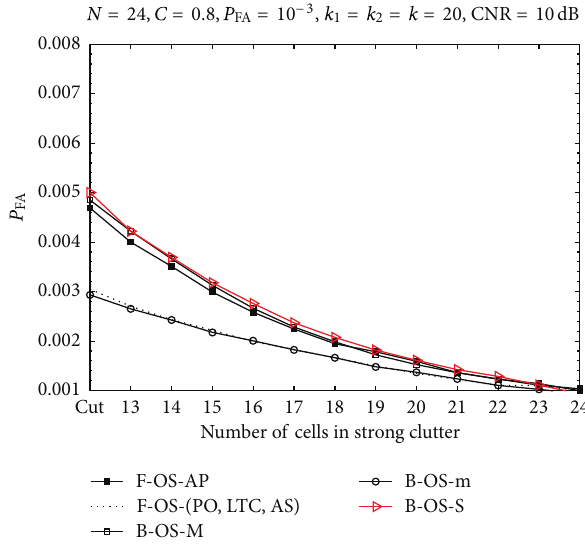
FA performance of detectors based on OS CFAR processorversusnumberofreferencewindowscellsinsensor1�lled with strong clutter when test cell (cut) and reference window